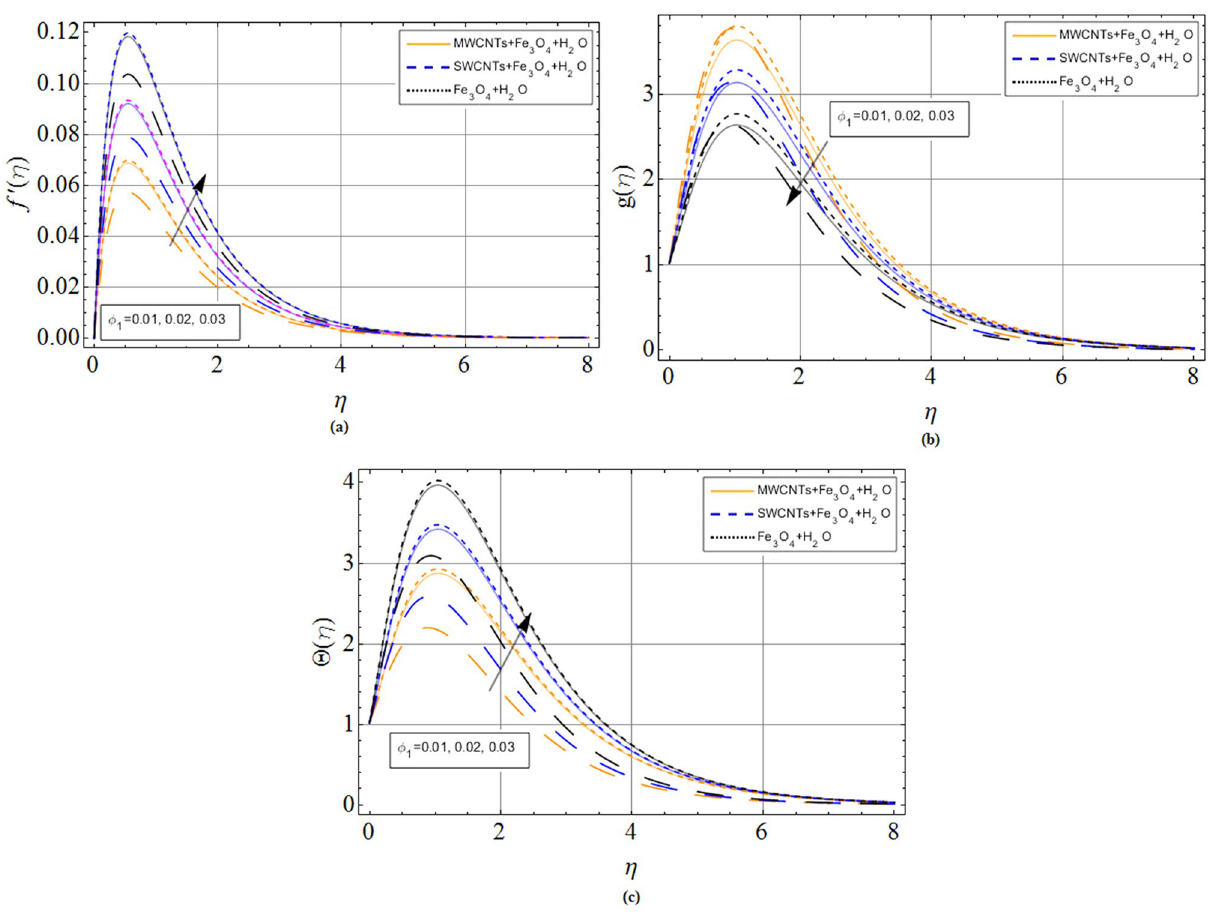
Figure 4. Volume friction parameter φ 1 ( CNTs ) effect on ( a ) axial velocity f ′ (η) ( b ) radial velocity g (η) ( c ) temperature �(η) . When φ 1 = 0.01, φ 2 = 0.2, Sc = 2.0, Pr = 6.2, M = 1.0, N =